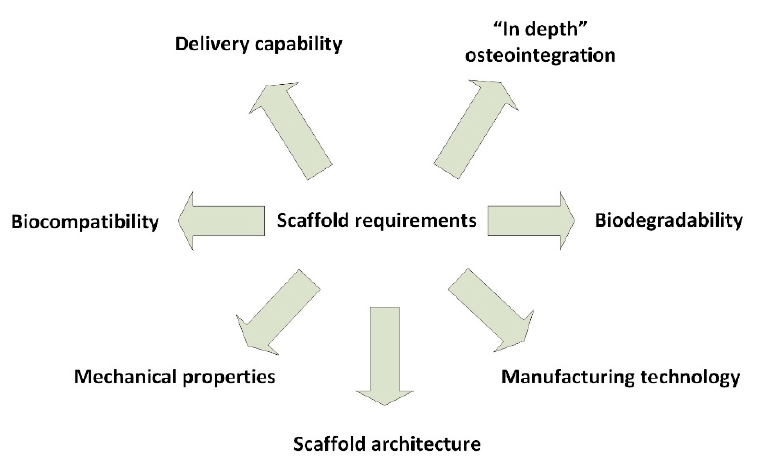
Figure 3. The key considerations for designing a scaffold or determining its effectiveness. Realized based on [24].